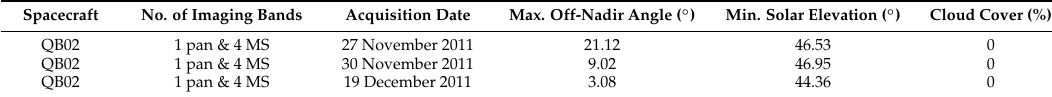
Table 1. Information on the acquired satellite data. Pan, panchromatic; MS, multispectral. Spacecraft No. of Imaging Bands